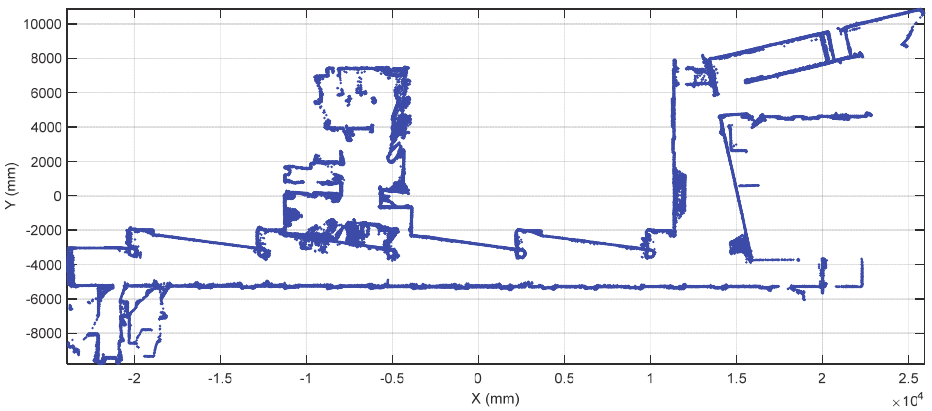
Figure 2. Reference point cloud map of the experimentation facility.